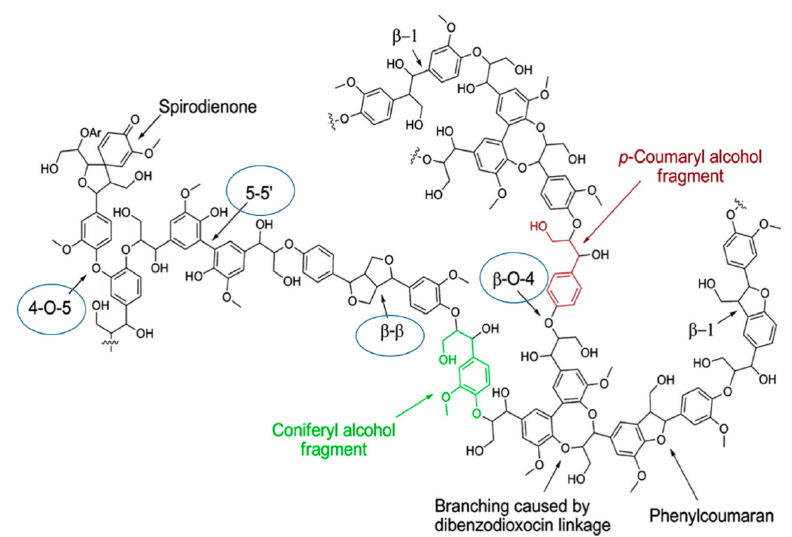
Figure 9. The supposed macromolecular structure of lignin rich in polyphenolic